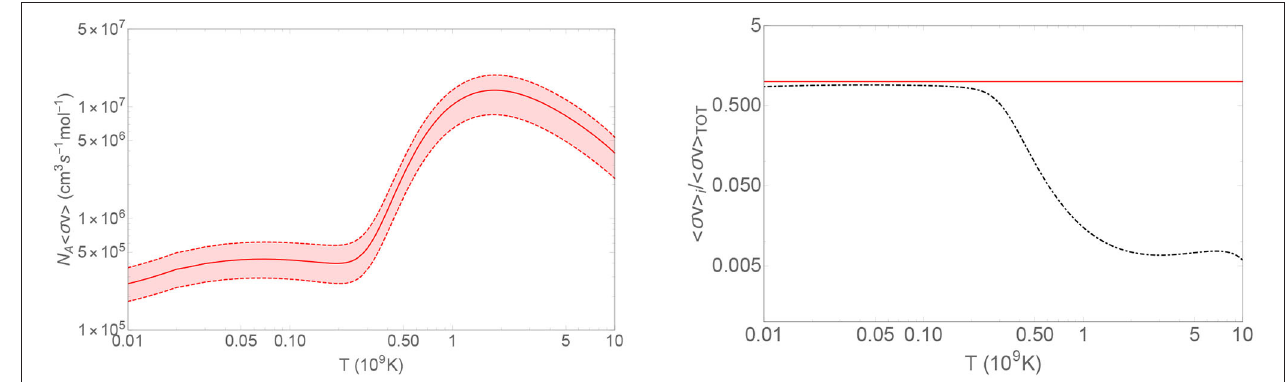
FIGURE 12 | (Left) The experimental TH reaction rate (red line). The red band represents the statistical and normalization errors. (Right) Contribution of the subthreshold resonant state to the total reaction rate.